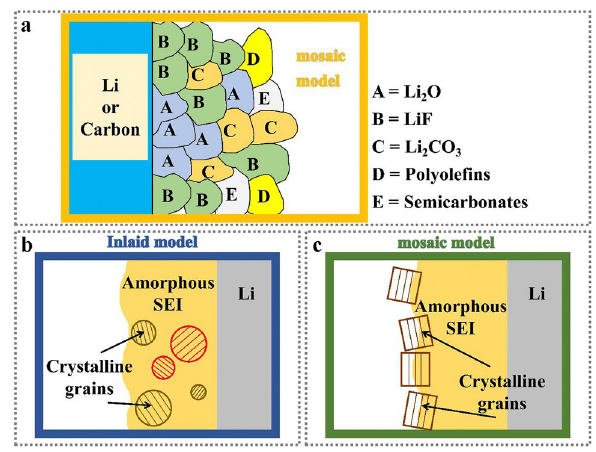
Fig. 2 a Schematic diagram of traditional SEI mosaic model; b Schematic diagram of SEI Inlaid model [29]; Copyright